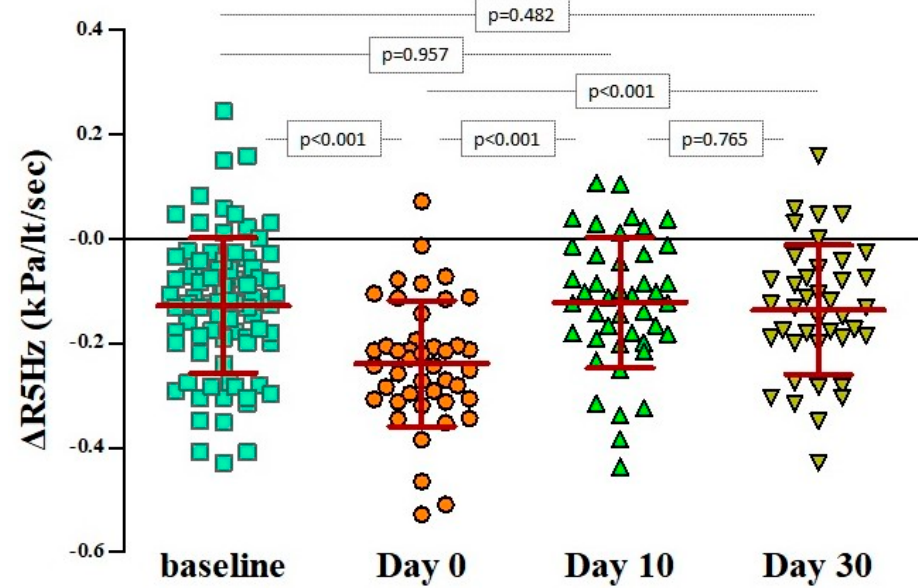
Figure 2. Pairwise comparisons of ∆ R5Hz values at baseline, on day 0 (beginning of the wheezing episode), and 10 and 30 days after. The bars and in-between lines represent the mean and SD. All pairwise comparisons are presented with p -values that have been estimated with paired Student’s t -test.; Pulmonary resistance (R) at 5 Hz (R5); ∆ R5Hz = (R5Hz post-bronchodilation – R5Hz pre-bronchodilation ) / R5Hz